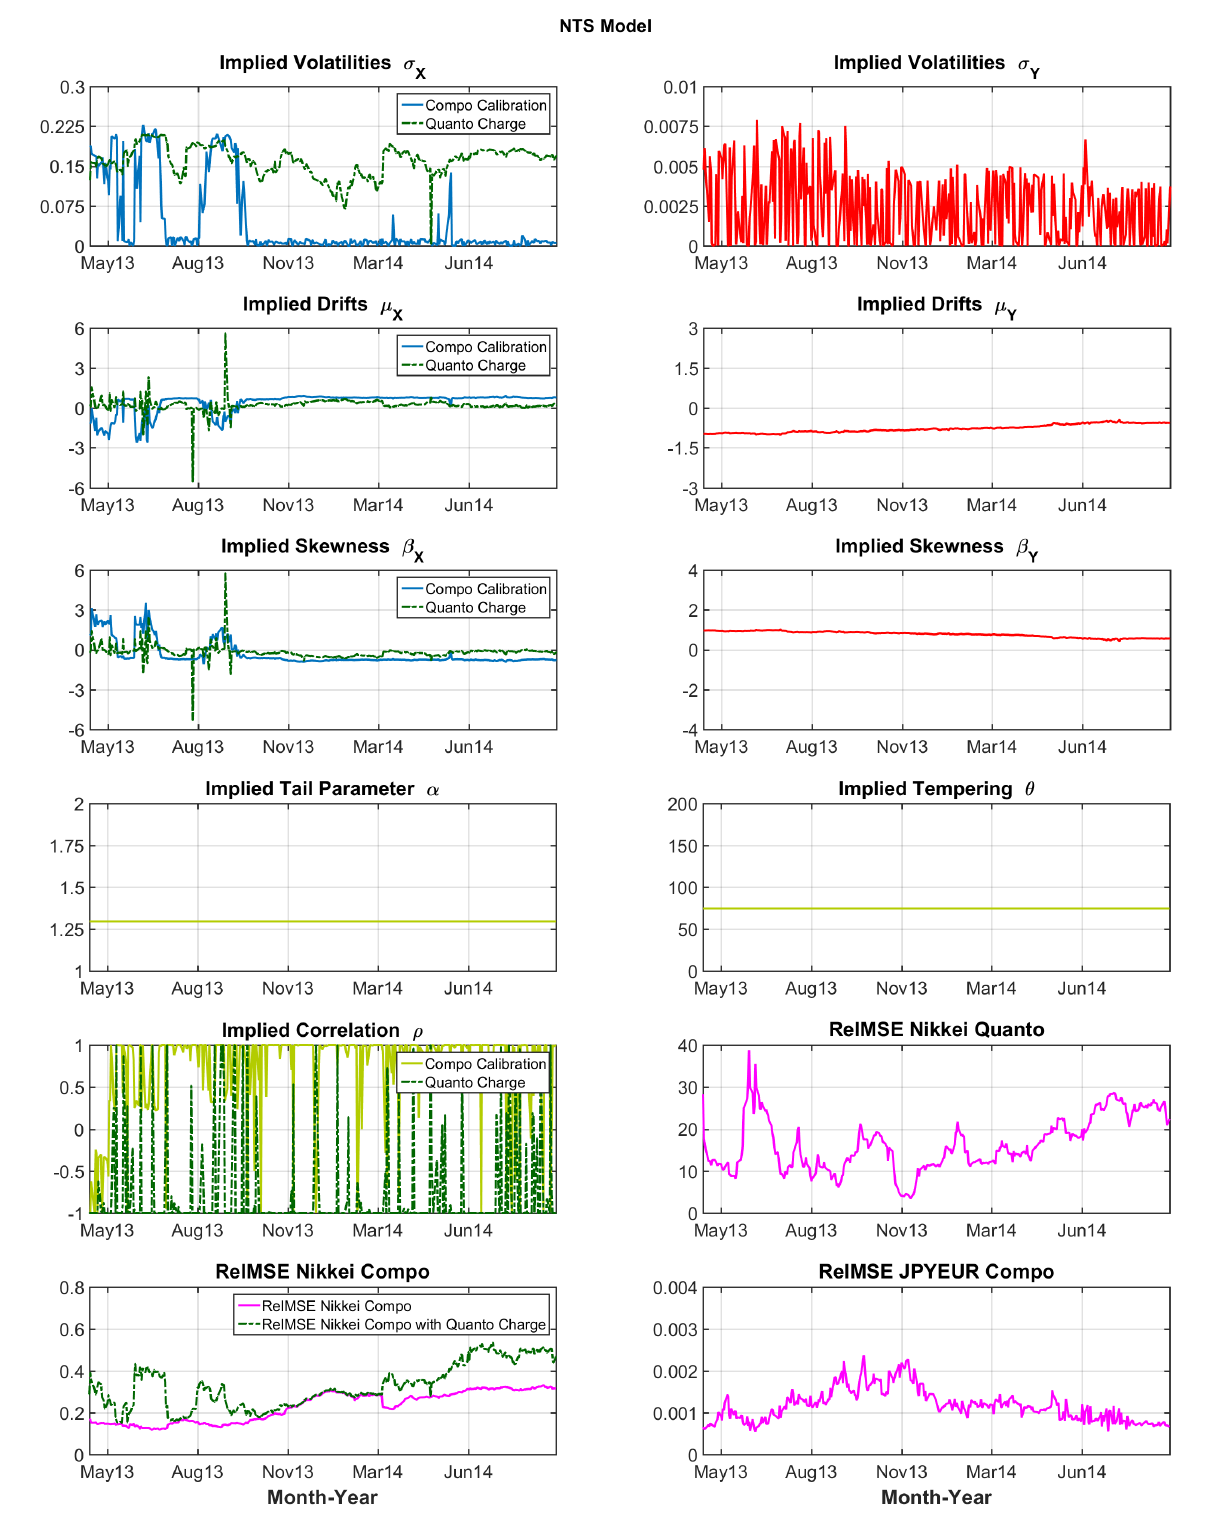
Figure 10. Quanto and compo options: daily calibrated ( X , Y ) NTS parameters and RelMSEs. Sample period 16 April 2013 to 15 September